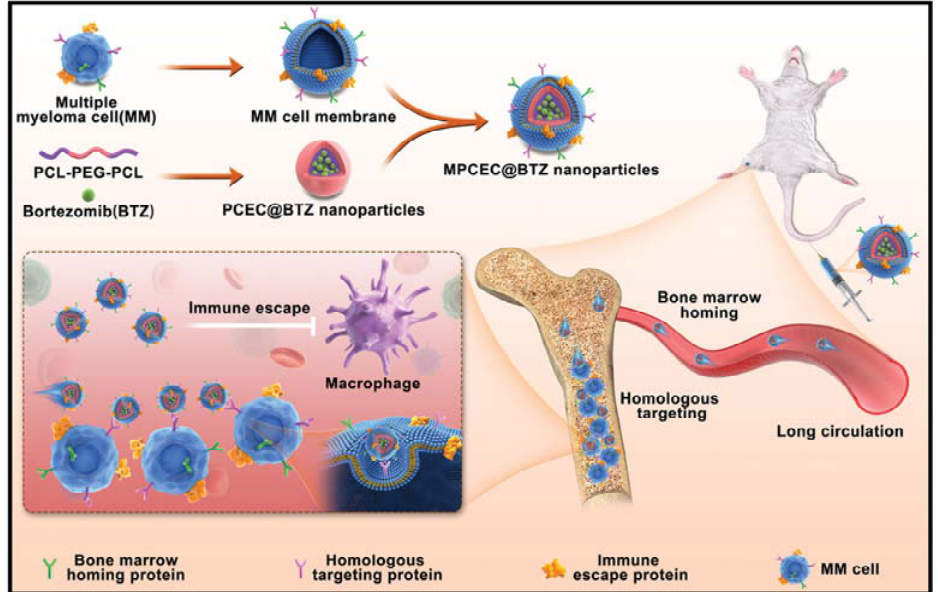
Figure 3. Targeting the tumour cells of nanoparticles loaded with Bortezomib and coated with MM cell membrane [125], Copyright 2022, Advanced Materials.